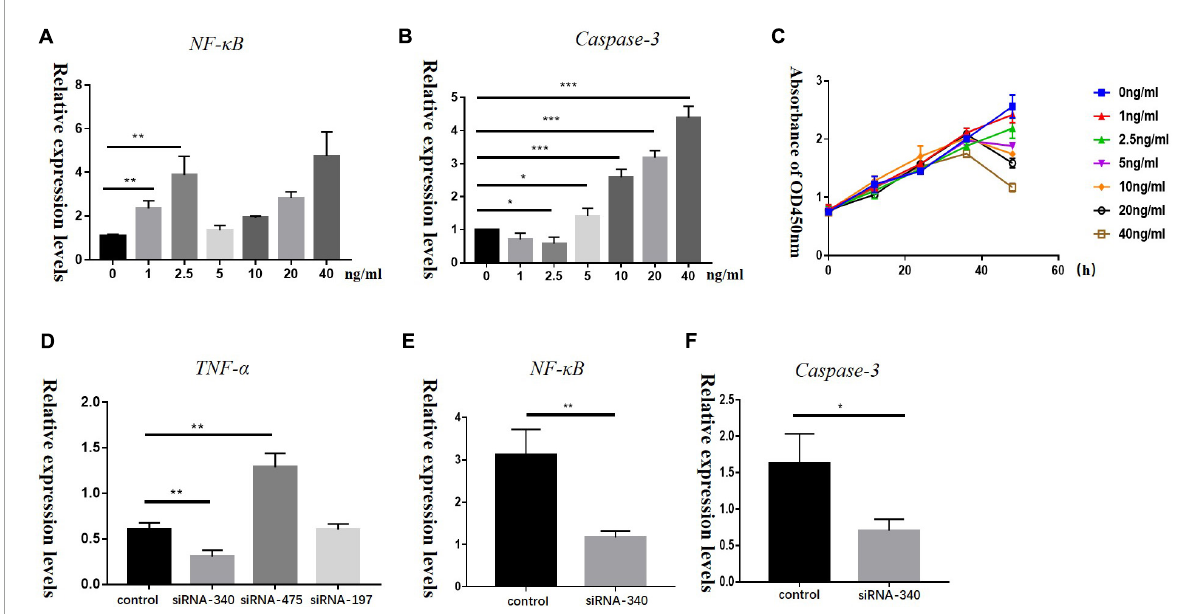
FIGURE5 Panels A,B show the relative mRNA expression levels of Nf-kb and Casp3 in HEI-OC1 cells treated with different concentrations of recombinant TNF- α (0, 1, 2.5, 5, 10, 20, and 40 ng/mL) for 72 h, (* P < 0.05, ** P < 0.01, *** P < 0.001). (C) A CCK-8 assay was used to detect the proliferation of HEI-OC1 cells treated with recombinant TNF- α for 12, 24, 36, and 48 h, OD: optical density. Panels D–F represent relative mRNA expression levels of Tnf-a , Nf-kb , and Casp3 in HEI-OC1 cells treated with siRNA-TNF- α for 72 h in control and blank groups, respectively (* P < 0.05, ** P <